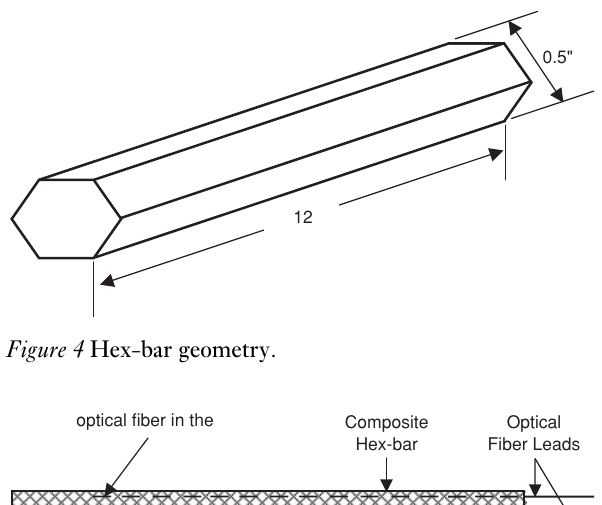
Figure 5 The optical fiber is placed between the first and second outer layers of the fiber